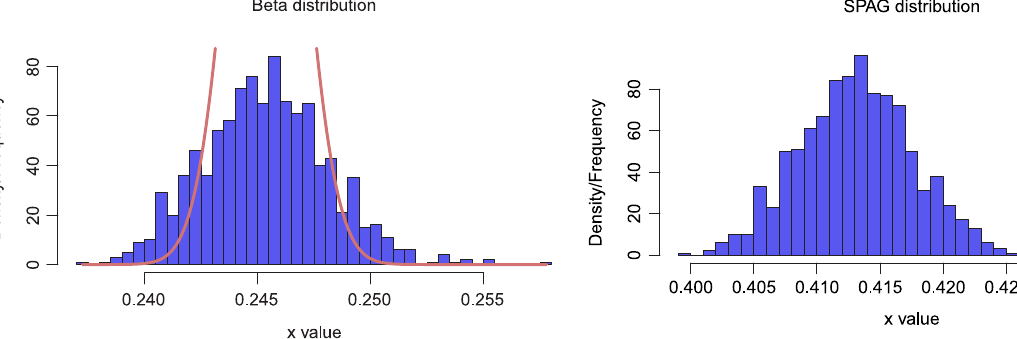
Fig. 6. Histogram for